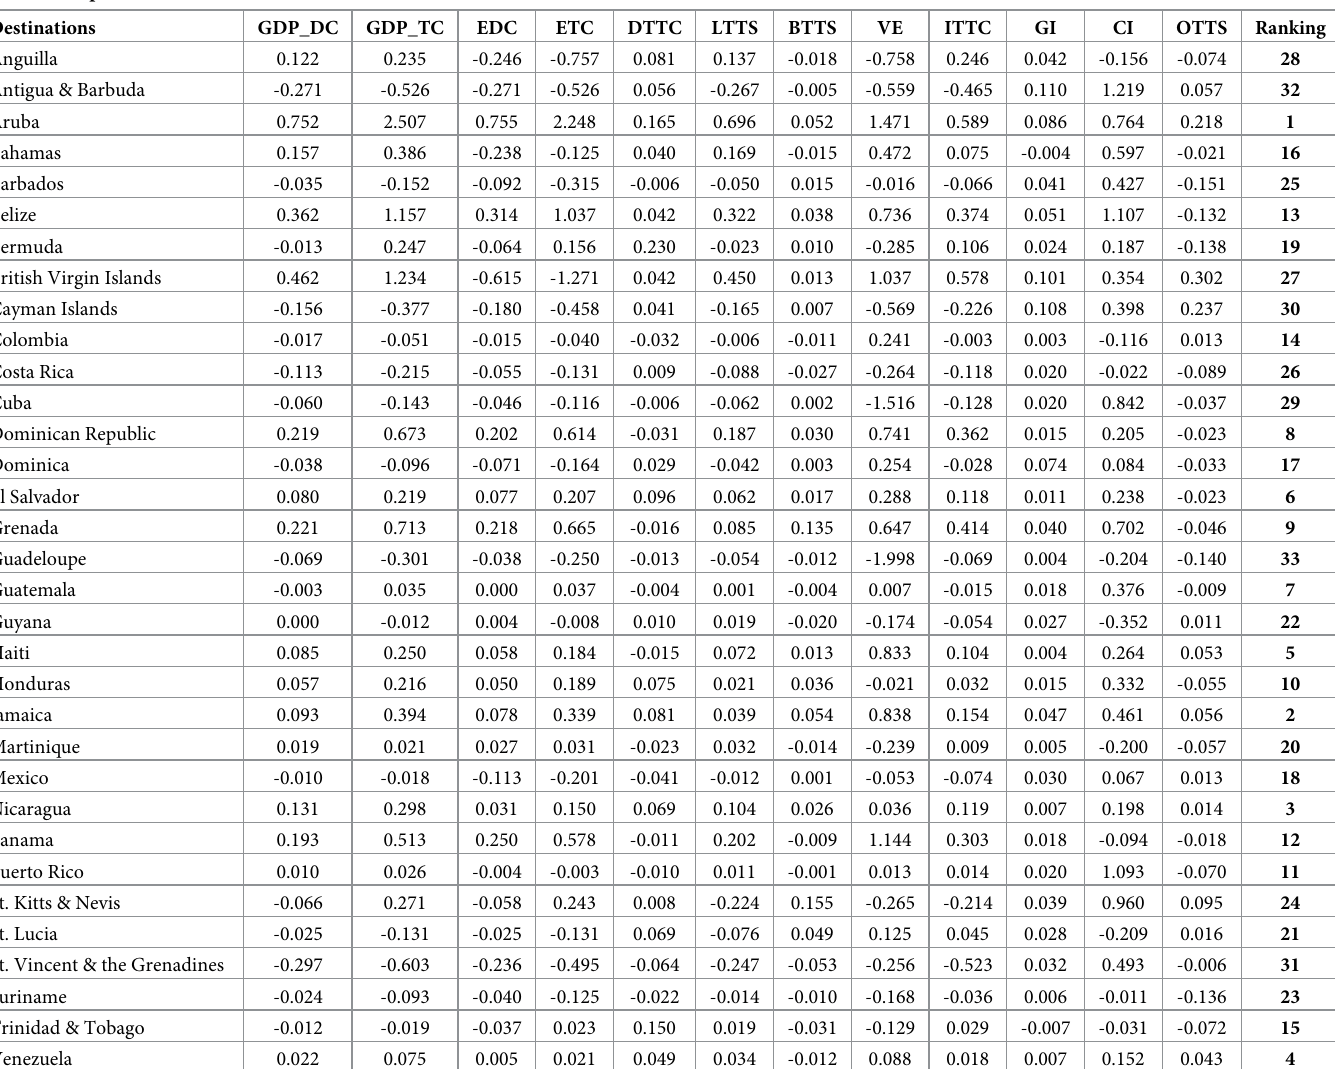
Table 1. Slopes of the